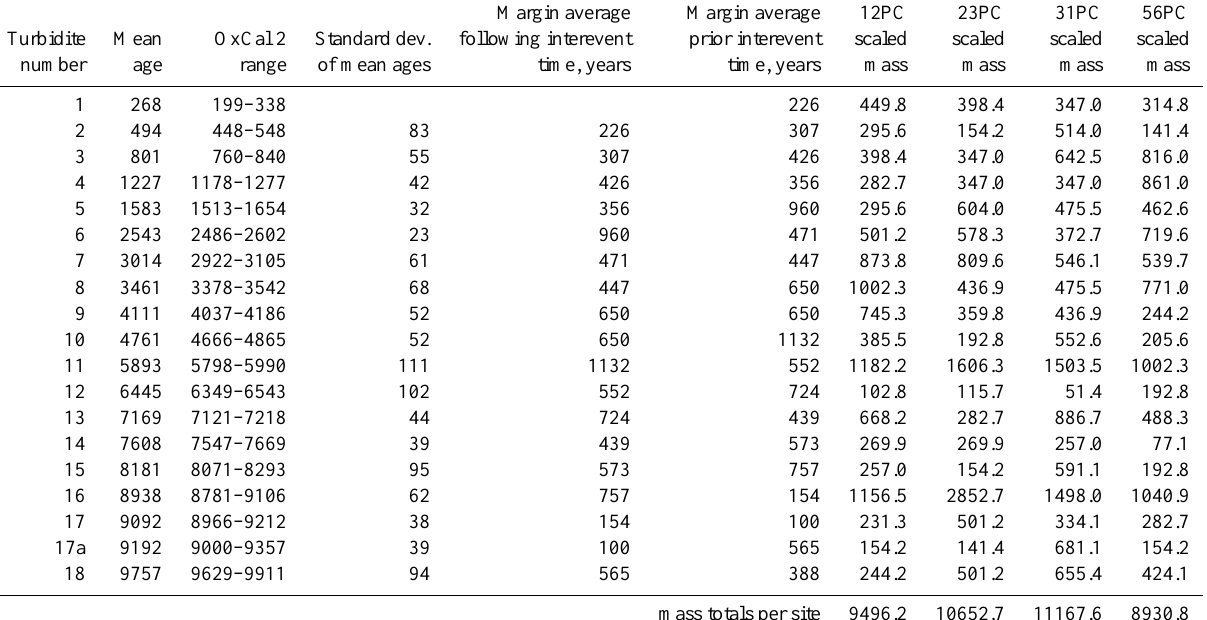
Table 2. Turbidite mass totals per site.